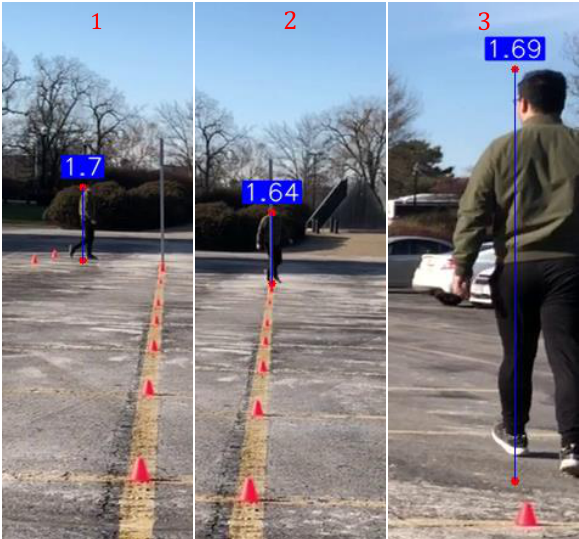
Figure 10. Person’s estimated height over frame. Yellow line is ground truth.